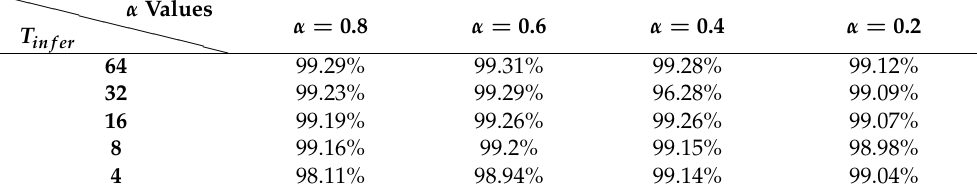
Table A2. Classification accuracy versus latency with differently scaled thresholds on the MNIST dataset.